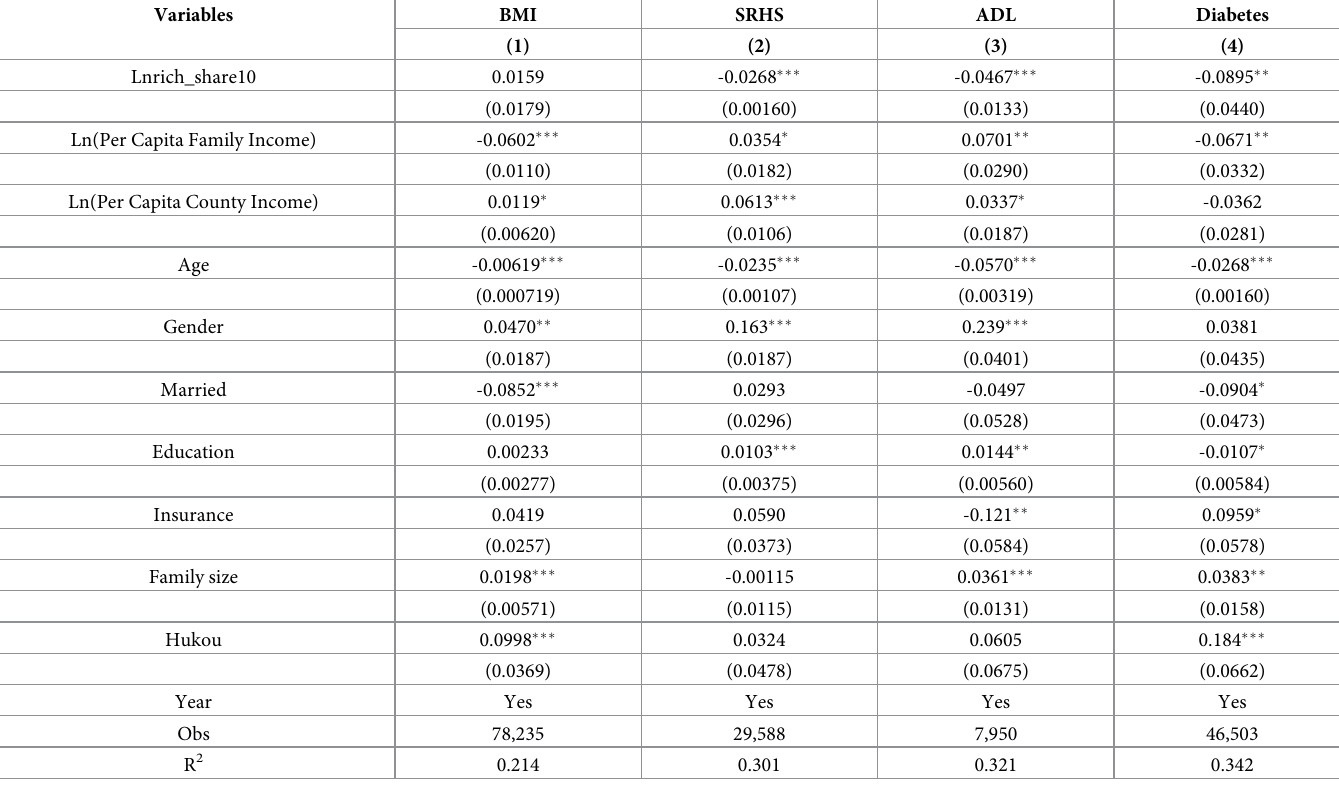
Table 3. The effects of rich share (10%) on individual